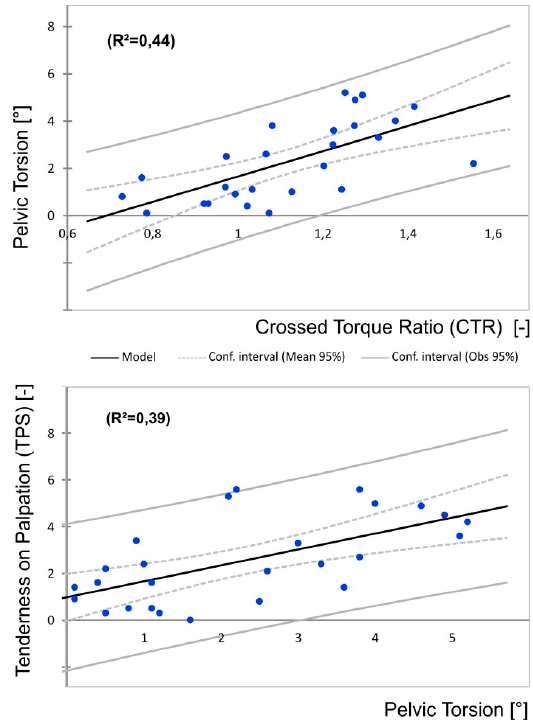
Figure 4. Regression of crossed torque ratio and pelvic torsion angle ( above ) and of pelvic torsion angle and tenderness on palpation ( below ).